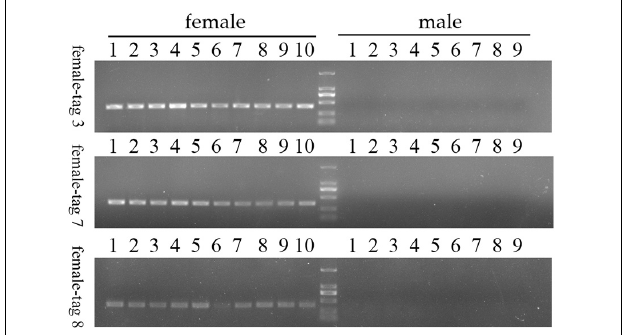
FIGURE 1 | Validation of three candidate female-specific 2b-RAD-tags in 10 females and 9 males. Label M represents the DL2,000 DNA